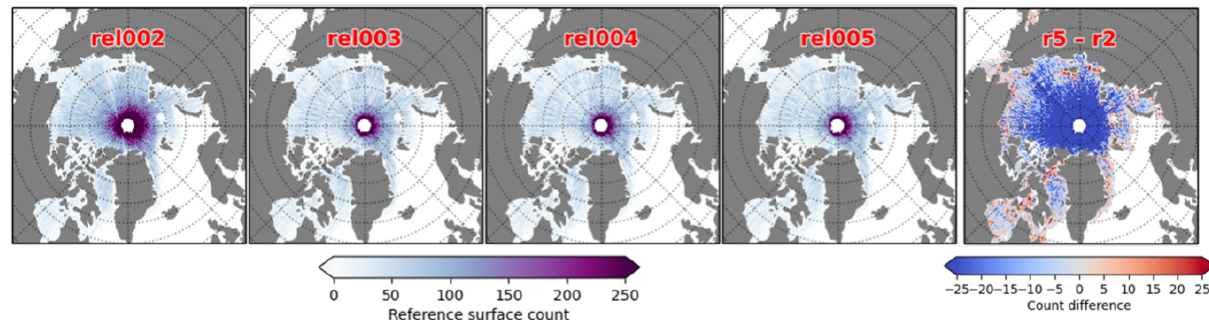
Figure 2. Number of 10km along-track reference sea surfaces from the three strong beams from November 2018 to April 2019 for Release 002/rel002 (left) through to Release 005/rel005 (fourth from left), and then (right) difference in reference surface counts between rel005 relative to